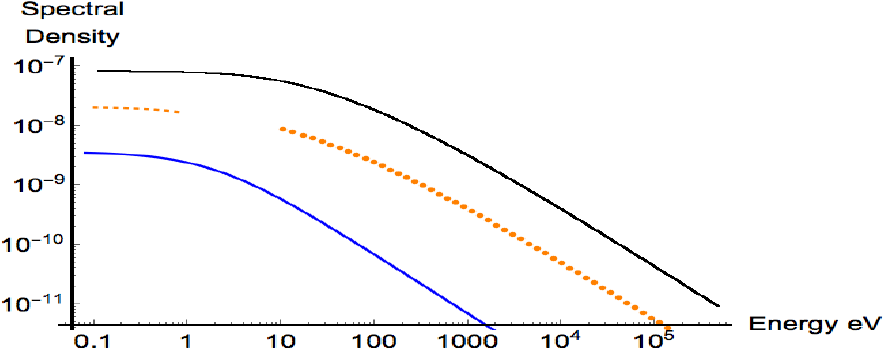
Figure 6. A log-log plot of the group theoretical spectral density for the 1S (black) and 2S (orange) shifts versus energy. The dashed orange curve below 1 eV is a 2S low-energy approximation (47) from group theory or the Bethe formula. The blue is the largest single contribution in the Bethe formalism to the 2S shift for the transition 2 S → 3 P